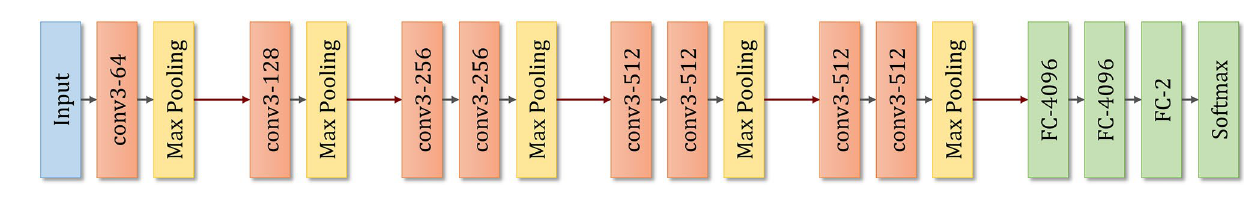
Figure 6. Architecture of the VGG-11 base